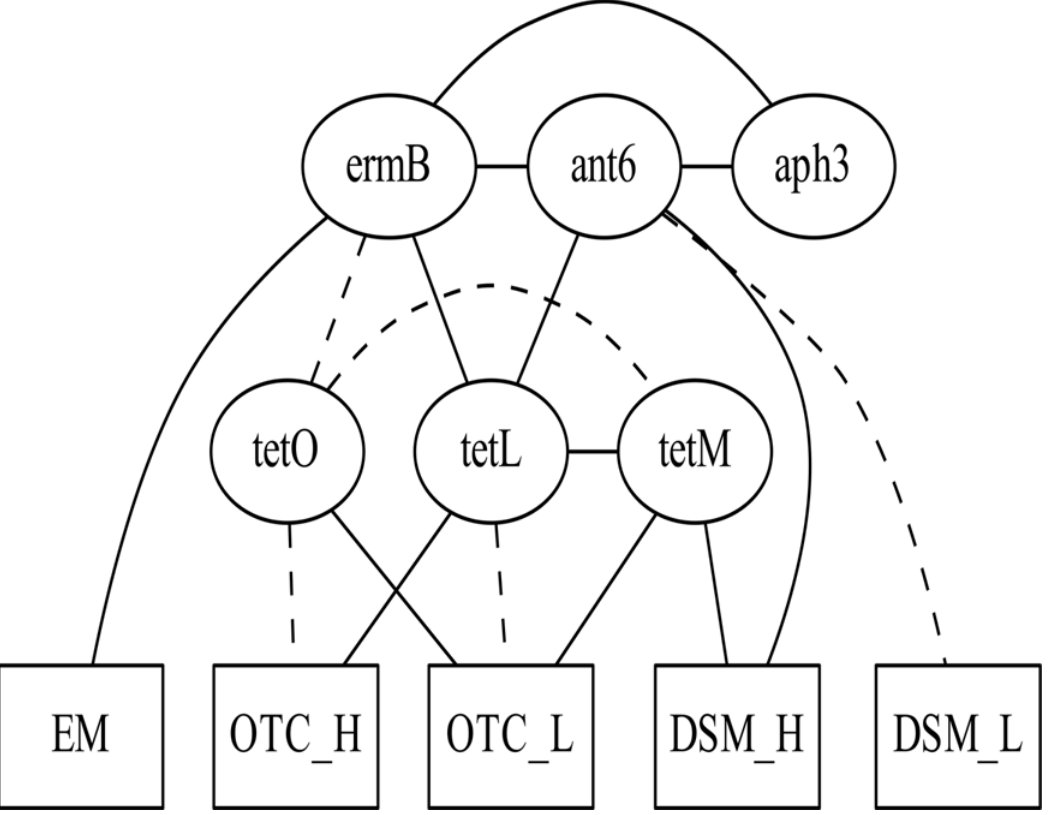
Fig 2. Initial optimal additive Bayesian network model. Identified interrelationships between selected antimicrobial resistance genes and their effects on the phenotypic expressions of resistance among 113 isolates of Enterococcus faecalis from domestic poultry products collected from retail shops in 5 major Japanese cities between July and August 2012. Abbreviations: ant6: ant (6)-Ia; aph3: aph (3 ’ )-IIIa; EM: erythromycin resistance; DSM_L: MIC for dihydrostreptomycin (cid:1) 128 μ g/mL and (cid:3) 512 μ g/mL; DSM_H: MIC for dihydrostreptomycin > 512 μ g/mL; OTC_L: MIC for oxytetracycline (cid:1) 16 μ g/mL and (cid:3) 64 μ g/mL; OTC_H: MIC for oxytetracycline > 64 μ g/mL. Solid lines and dashed lines represent positive and negative associations between variables, respectively.